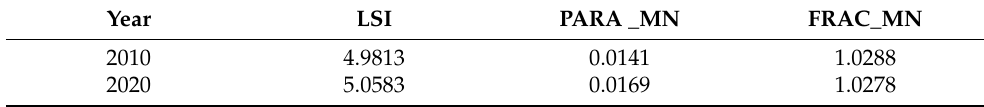
Table 3. The landscape metrics of rural settlements in Pingyin County from between